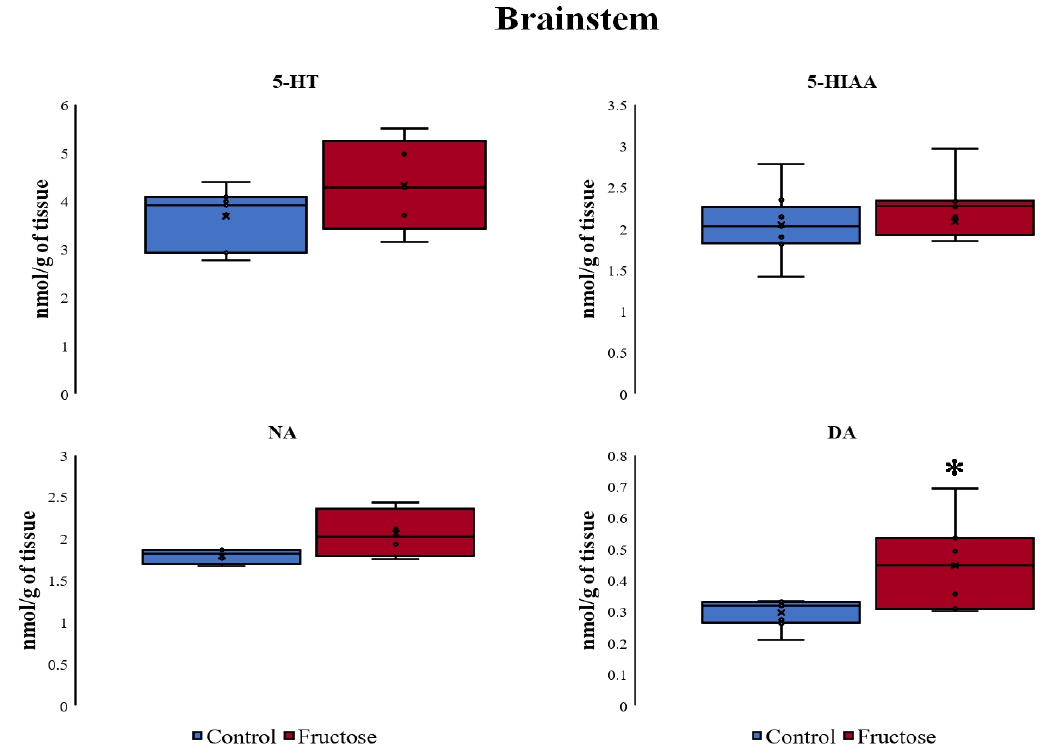
Figure 5. Concentration of monoamines in the hypothalamus and brainstem after the chronic ingestion of fructose. Other abbreviations used: serotonin (5-HT), 5-hydroxyindolacetic acid (5-HIAA) and noradrenaline (NA). Box plots represent the median, interquartile range, and minimum and maximum values. N = 4–6 per group. The differences between the groups were analyzed with a Mann–Whitney rank sum test (* p < 0.05 vs. control group).